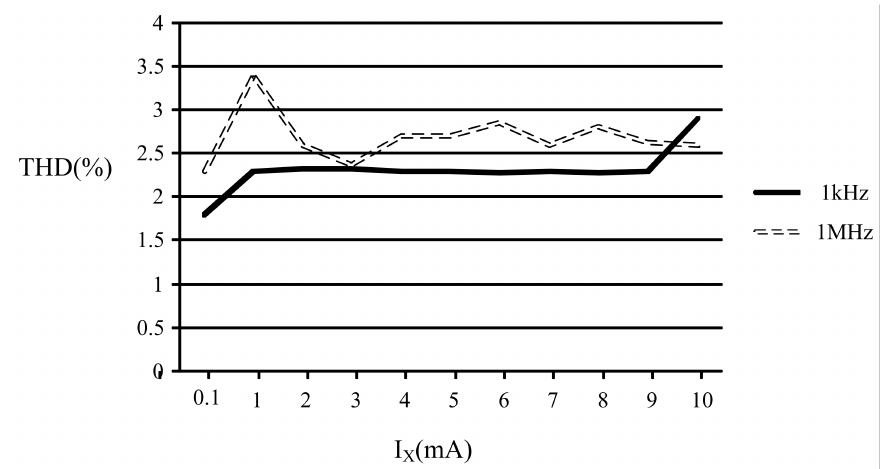
Figure 12. THD for different amplitudes of I X at frequencies of 1 kHz and 1 MHz.